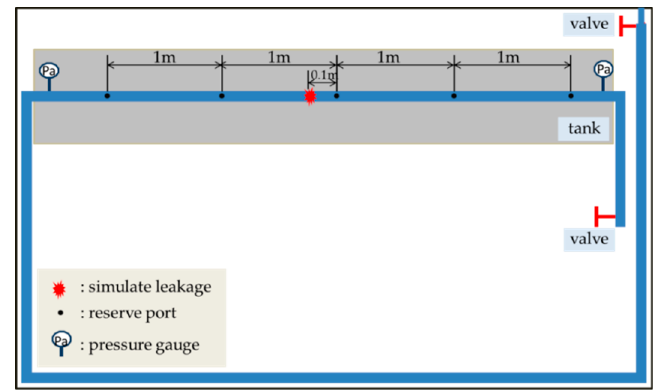
Figure 4. Schematic diagram of the test pipe system.